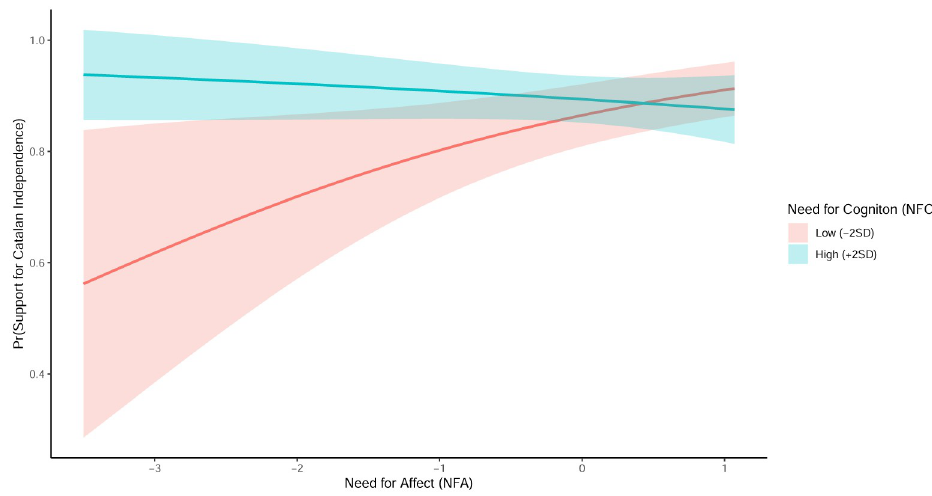
Fig 4. Marginal effects of NFA on desire for Catalan independence conditional on NFC. Note : Predictions are based on Model 6 from Table 1.